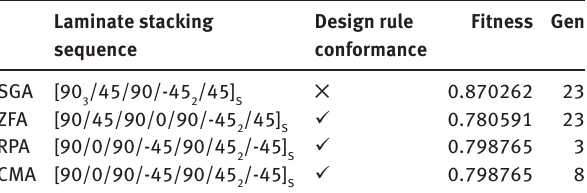
Table 5 Optimal results for rule